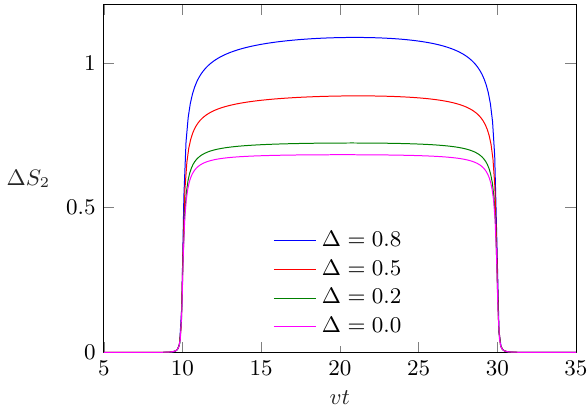
Figure 4: Time evolution of the excess Rényi entropy in Eq. (50) after the Majorana excitation with (cid:96) = 20, d = 10 and ε =